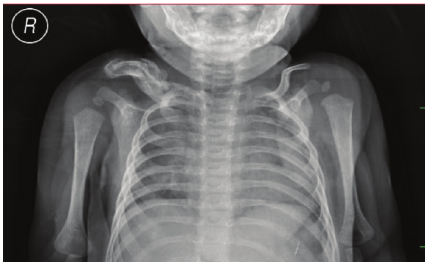
Figure 2: Radiograph showing extensive active osteomyelitis of middle third clavicle with sequestrum and involucrum.